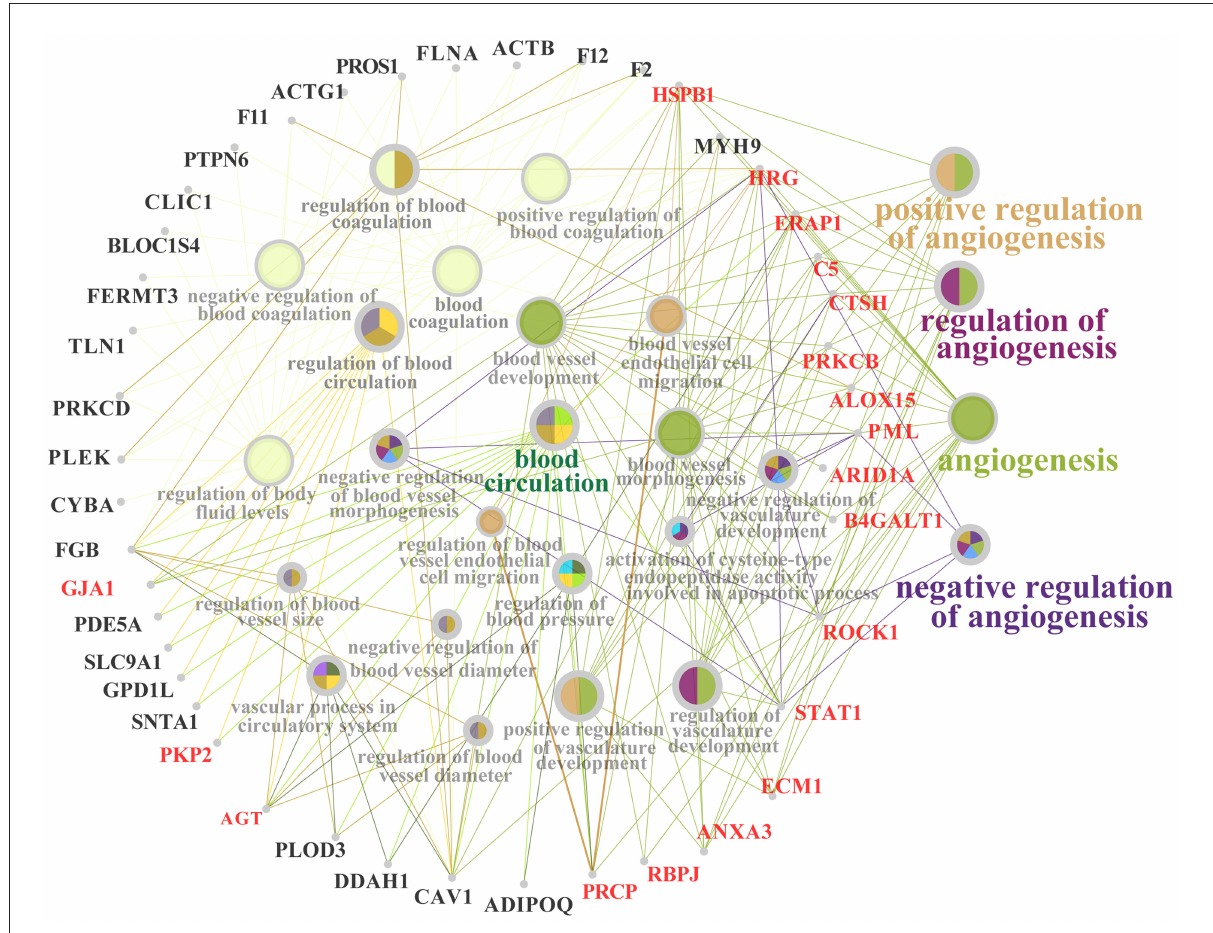
FIGURE4 PPI network of the 59 candidate DEPs and 25 GO terms related to blood, vascular and